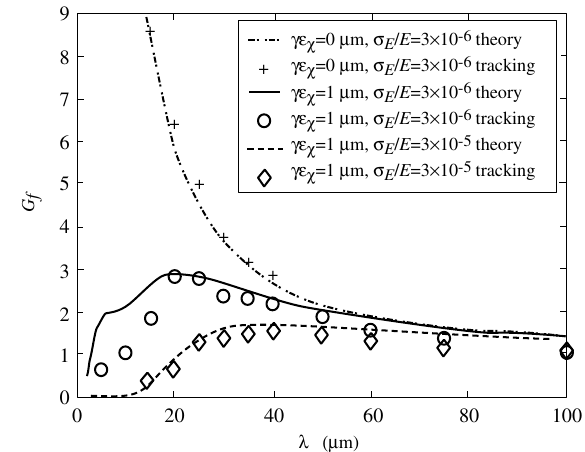
FIG. 7. Gain spectrum of microbunching modulation in the SLAC BC2 compressor at different input energy spread and emittances.